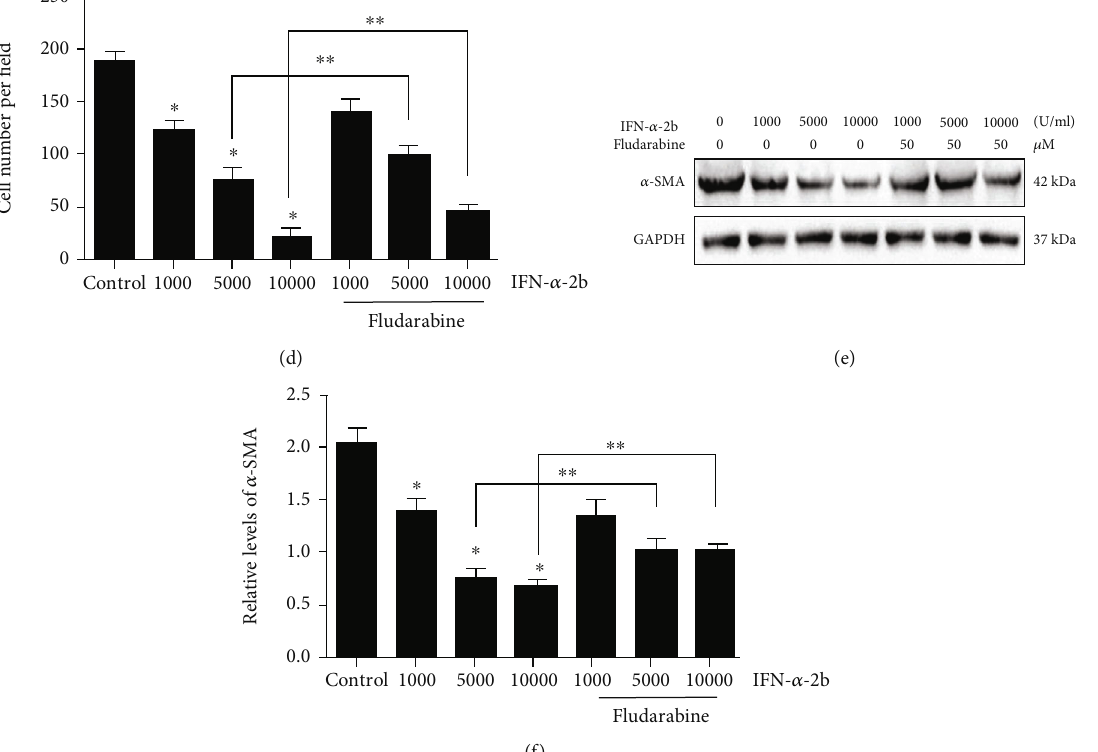
Figure 6: IFN- α -2b inhibits the migration of fi broblasts by STAT1/P21 signaling pathway. (a, b) In vitro wound healing experiments showed that the IFN- α -2b treatment group signi fi cantly inhibited the migration rate of fi broblasts. (c, d) Compared with the control group, the number of cells passing through the cell bottom membrane in the IFN- α -2b treatment group was signi fi cantly reduced. And it is concentration-dependent. (e, f) Western blotting shows that the IFN- α -2b treatment group can reduce the relative expression level of α -SMA, while the fl udarabine and IFN- α -2b coapplication groups can partially reverse the above-mentioned inhibitory trend of IFN- α - 2b. Each sample randomly selects 10 microscope fi elds and conducts 3 independent experiments. ∗ Compared with the control group. ∗∗ Compared between the two groups, P < 0 : 05 ( n = 3